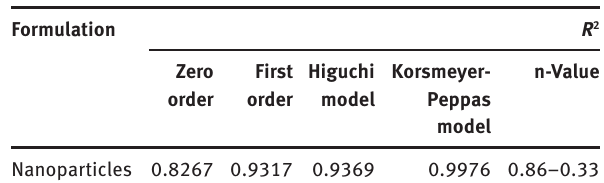
Table 5: Value of regression obtained from different kinetic